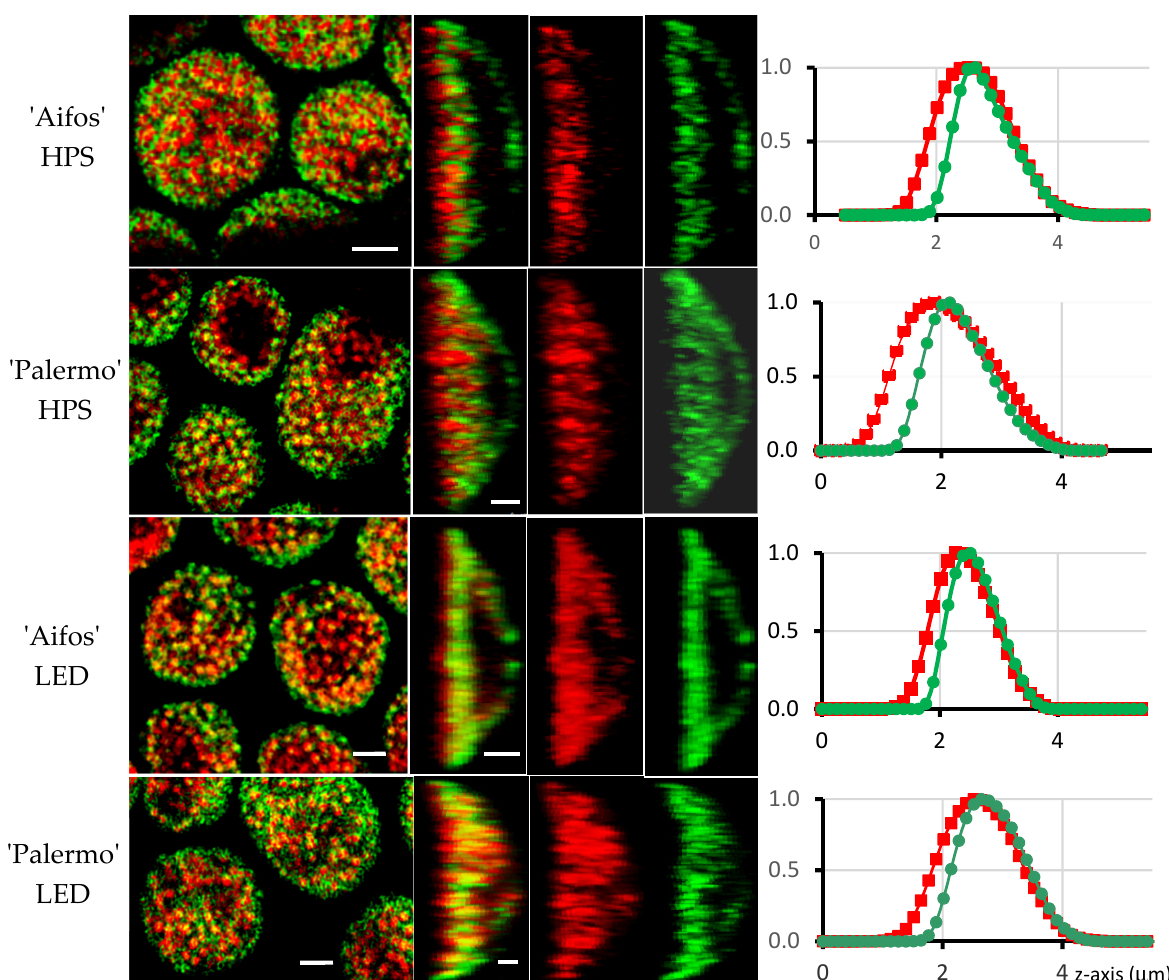
Figure 6. Fluorescence levels of chlorophyll and carotenoids (false red and green colors, respectively) in chloroplasts of pepper leaves (cv. ‘Aifos’ or ‘Palermo’). Sunlight was supplemented with sodium lamps (HPS) or diode (LED) actinic light. First (left) column: Fluorescence of chlorophyll and carotenoids (merged images) in single-median optical sections (x:y mode of scanning) through groups of chloroplasts. Note that granum structures are represented by red discs. Second column: Median optical sections along the z -axis of chloroplasts. Fluorescence levels of chlorophyll and carotenoids—merged images. Last two columns: Fluorescence levels of chlorophyll and carotenoids are shown separately. Line graphs levels ( y -axis, normalized) for chlorophyll (red line) and carotenoids (green line), while the z -axis show changes in fluorescence intensity (µm) for chloroplasts starting from the bottom side (value 0) to the top (value 4) of the organelles. Note that the fluorescence of chlorophyll always exceeds the values of the carotenoids when starting from the bottom of the chloroplasts to the top. Abbreviations: star—starch granule. Scale bars—2 µm.